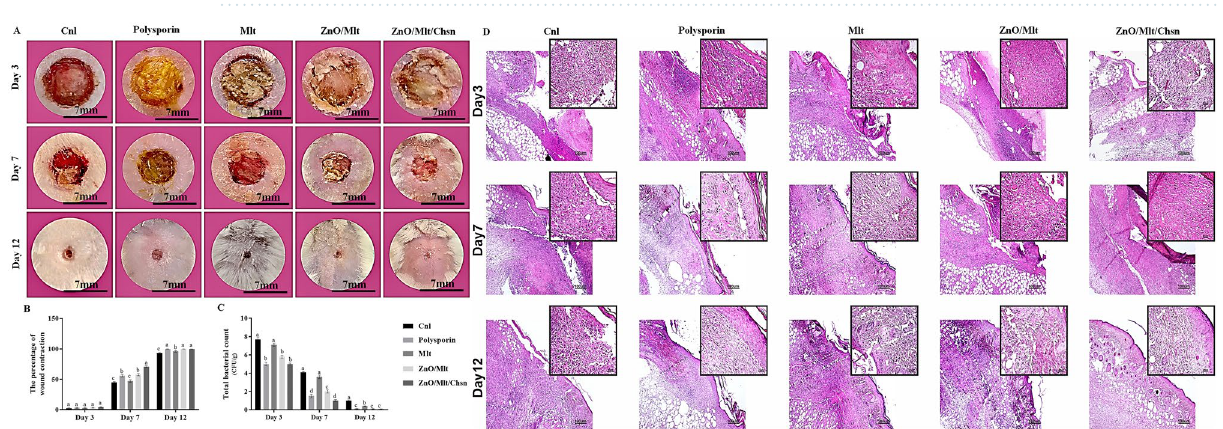
Figure 9. ( A ) Illustration of infected full-thickness wounds in the experimental group on different days after the wounding; ( B ) Wound area (mm 2 ) for Cnl, polysporin, Mlt, ZnO/Mlt, and ZnO/Mlt/Chsn. The letters (a–d) indicate significant differences between the groups on the same day; ( C ) Total bacterial count (CFU/g) for Mlt, ZnO/Mlt, and ZnO/Mlt/Chsn. The letters (a–e) indicate significant differences between the groups on the same day. ( D ) Representative photomicrographs stained with the hemotoxiline and eosin staining for the wound area in Cnl, polysporin, Mlt, ZnO/Mlt, and ZnO/Mlt/Chsn